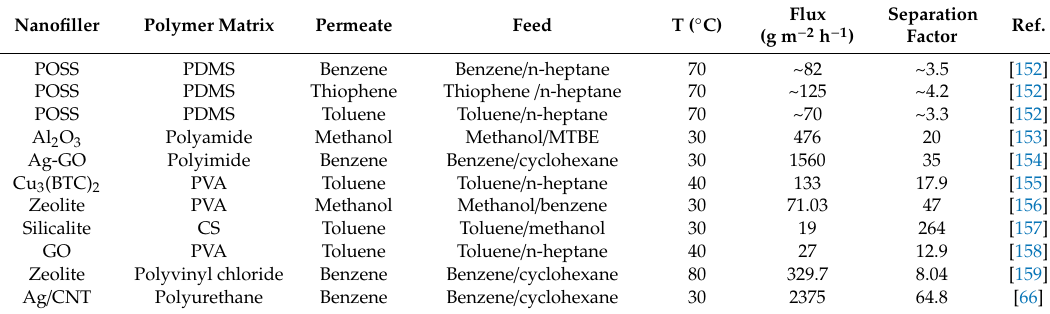
Table 5. Other MMMs used in PV separations of organics from organic